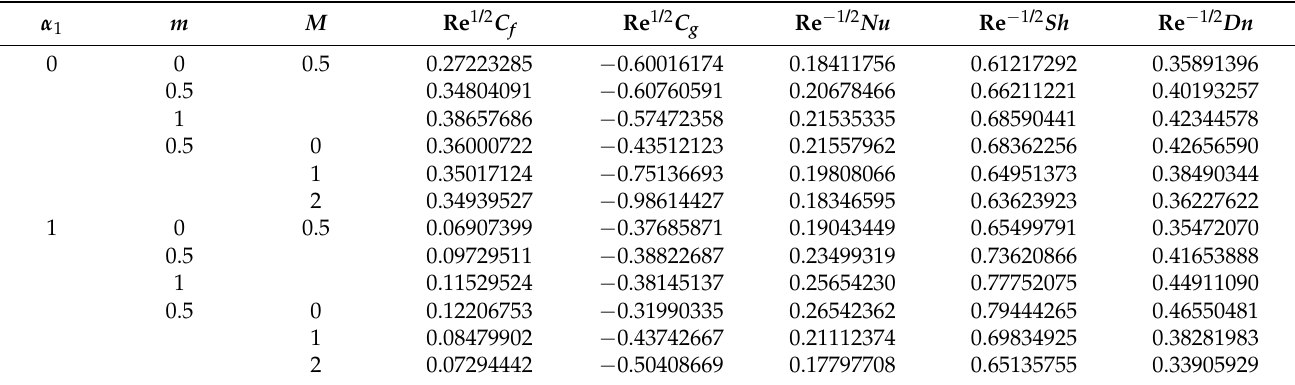
Table 2. The values of Re 1/2 C f , Re 1/2 C g , Re − 1/2 Nu , Re − 1/2 Sh , and Re − 1/2 Dn for different values of